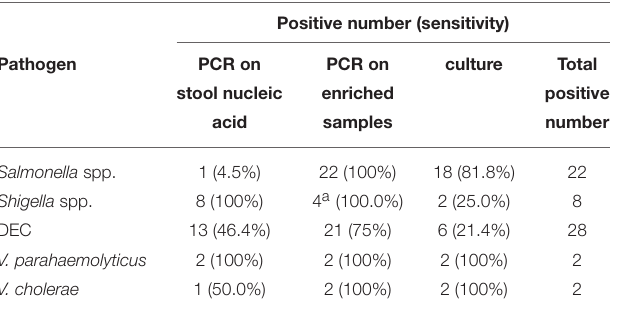
TABLE 5 | Positive sample numbers and sensitivities of different methods for different pathogens.